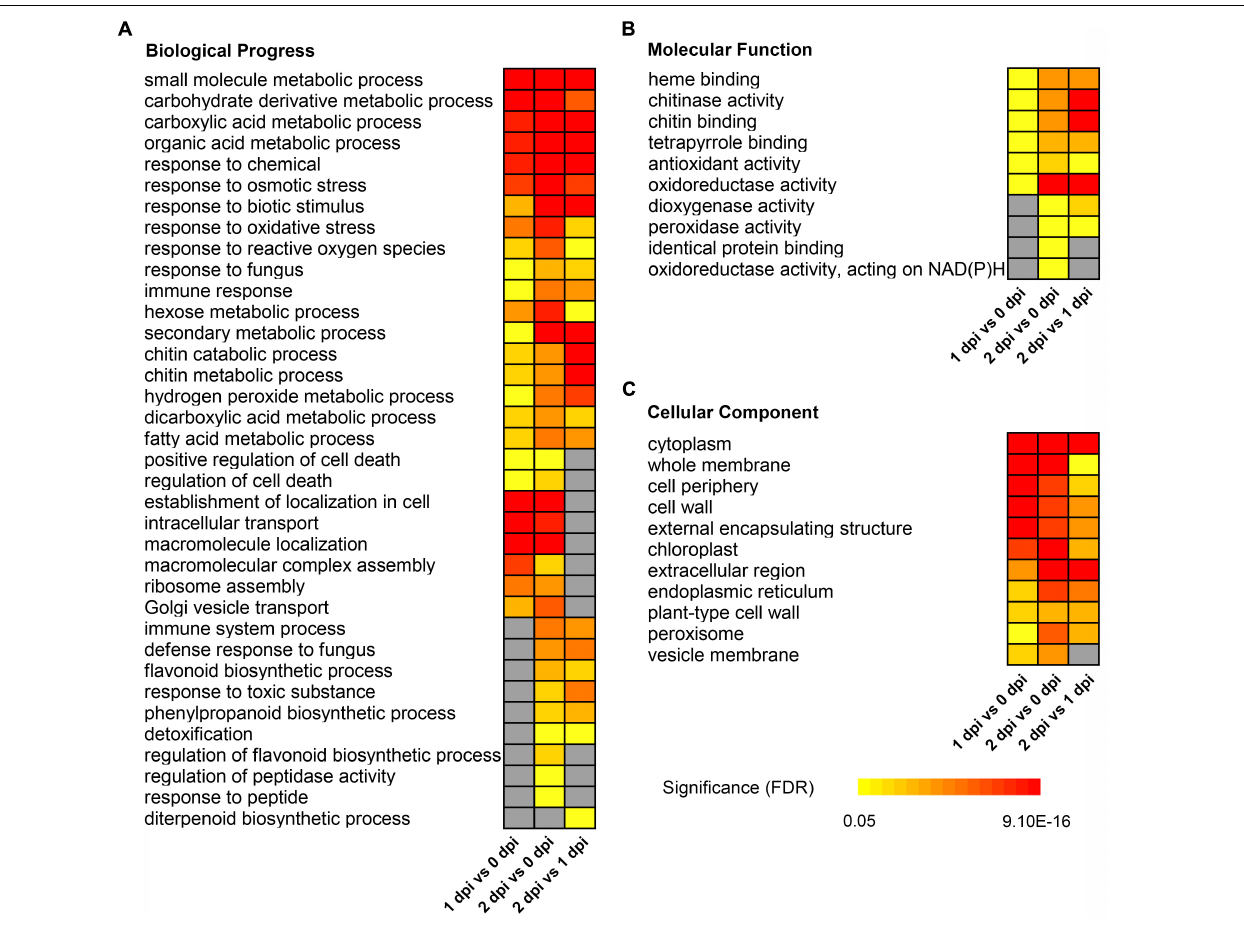
FIGURE 3 | Gene ontology enrichment of up-regulated differentially expressed proteins between 0, 1, and 2 dpi. Enriched GO terms showed in biological progress (A) , molecular function (B) , and cellular component (C) . (C) The colors from yellow to red represent the significance level of the GO terms from high to low. Fisher’s exact test, P -value was adjusted using the Benjamini-Yekutieli method, FDR <